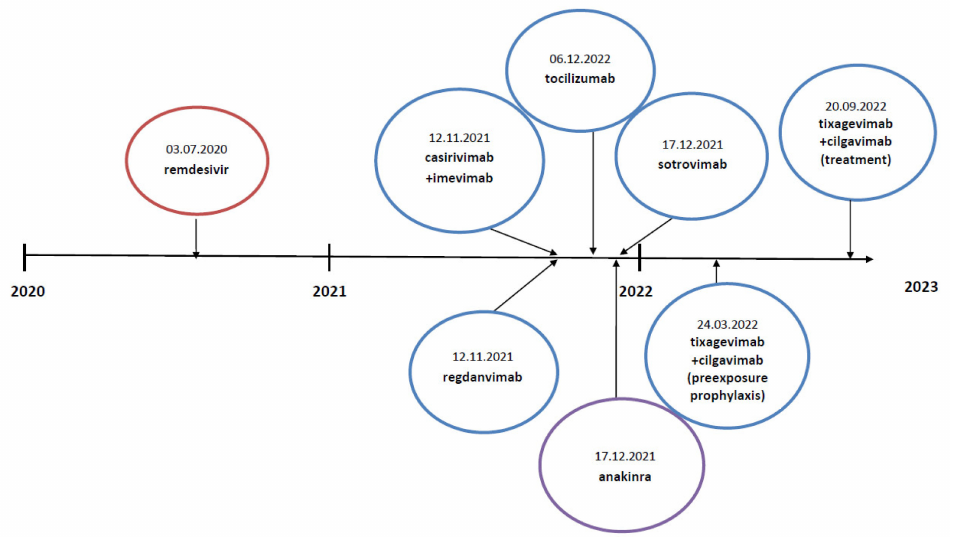
Figure 1. History of drugs for COVID-19 treatment registered by the European Medicines Agency